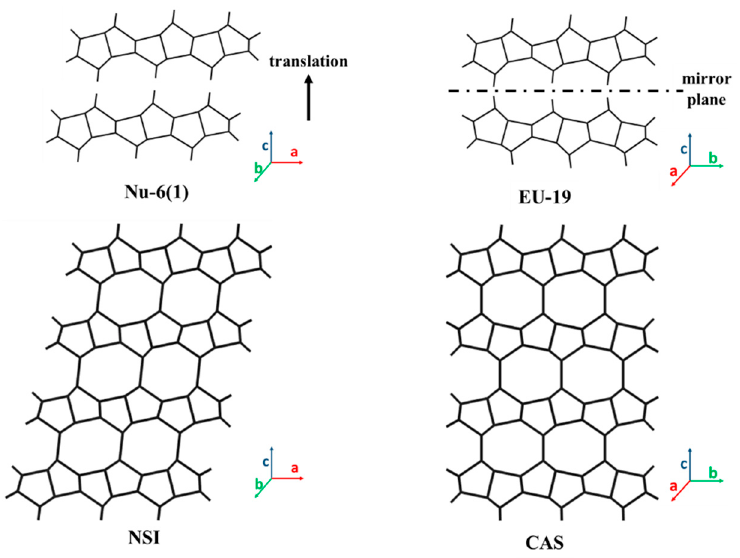
Figure 4. Schematic illustration of structures of 2D layered precursors and the corresponding NSI and CAS zeolites.